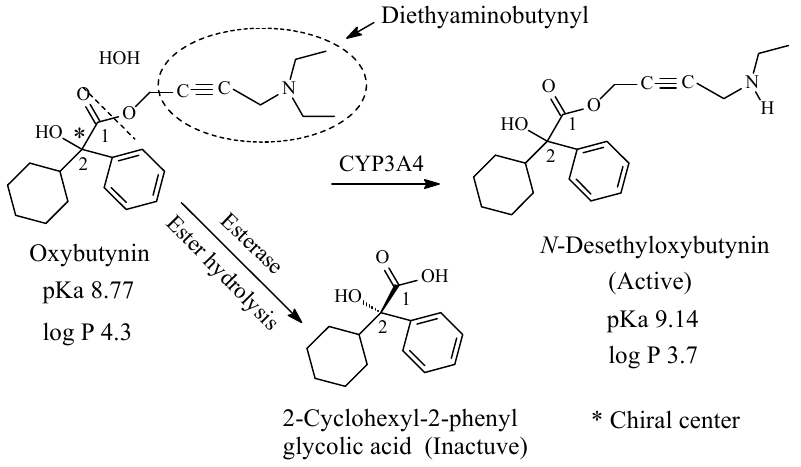
Figure 35. Metabolic pathways of oxybutynin.